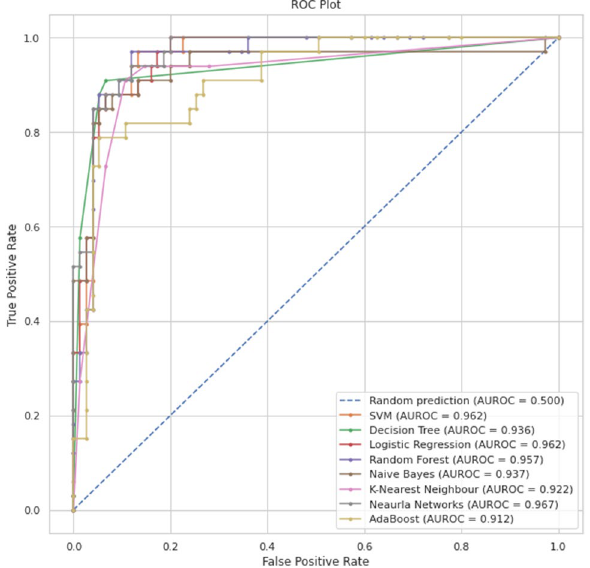
Figure 12. AUC of the eight classifier